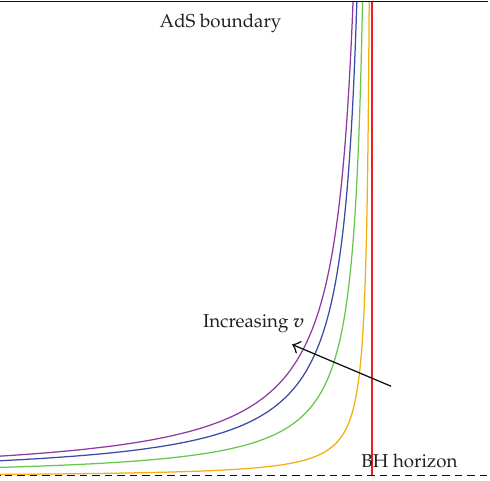
Figure 2: The trailing string solution in Schwarzschild-AdS 4 spacetime. The curves are drawn for di ff ering values of the quark velocity v (cid:3) specifically from right to left, v (cid:7) 0 , 0 . 15 , 0 . 5 , 0 . 8, and 0 . 99999 (cid:4) on the